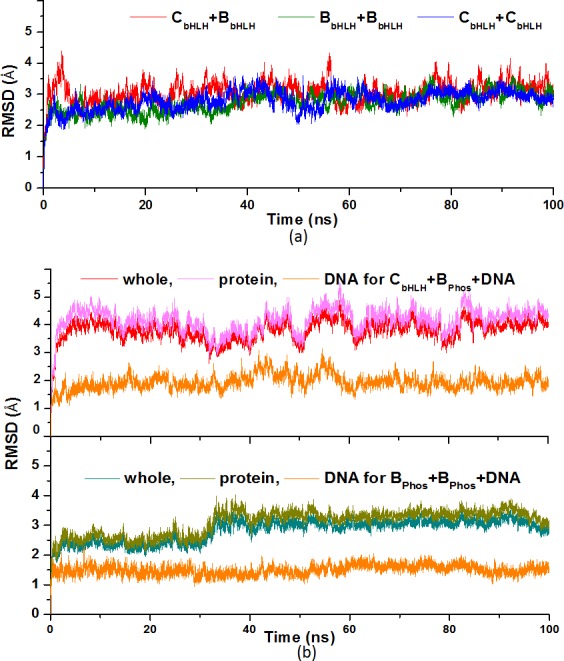
RMSD values of the binary and phosphorylated models.RMSD values of all heavy atoms with respect to the corresponding starting structures for MD simulations of (a) the CbHLH+BbHLH, BbHLH+BbHLH and CbHLH+CbHLH models, and (b) the CbHLH+BPhos+DNA and BPhos+BPhos+DNA models.